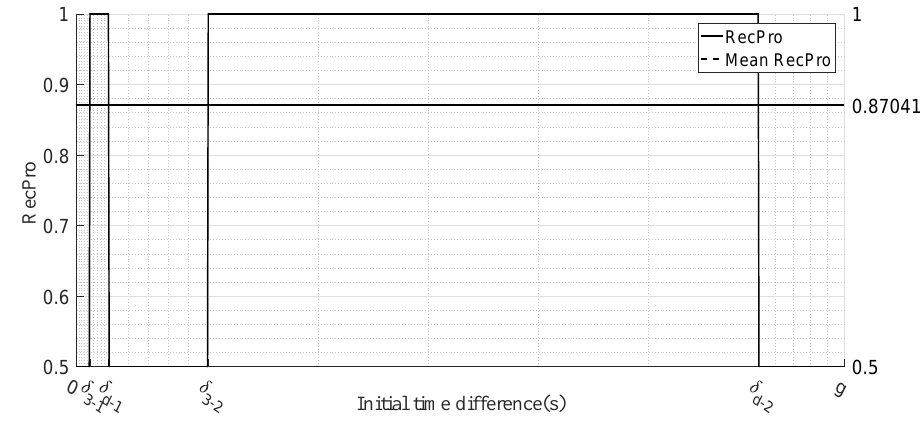
Figure 9. The recognition probability vs initial